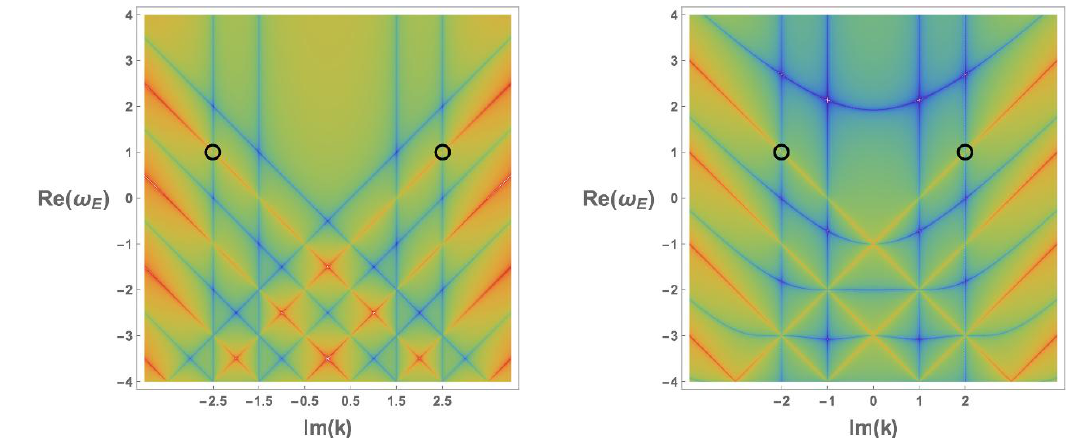
Figure 2 . Plots of log jG 00 ; 00 ( ! E ; k ) j in d = 5 (left) and d = 4 (right). The \warm" lines (or- ange/red) correspond to poles. The \cold" lines (blue) correspond to zeros. The four vertical zero lines are due to the polynomial prefactors in (5.19) and (5.26). Pole skipping occurs when zero lines and pole lines intersect. In order to make a connection with exponentially growing modes in quantum chaos, one should focus on the upper half plane, where pole skipping is observed at precisely two locations (black circles): ( ! E ; k ) skip = (1 ; (cid:6) i d ). Note that in the even dimensional 2 case (right (cid:12)gure) the precise shape of the zero lines (but not the pole skipping locations) depend on ambiguous contact